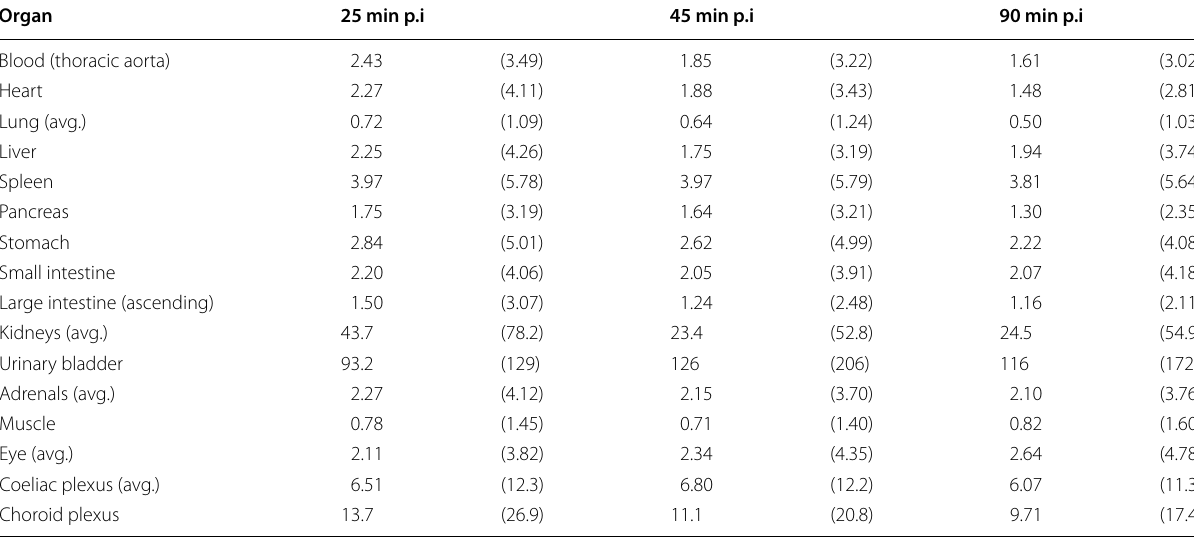
; SUV in parentheses) for selected areas of a PET scan in human (Fig. 7) mean max